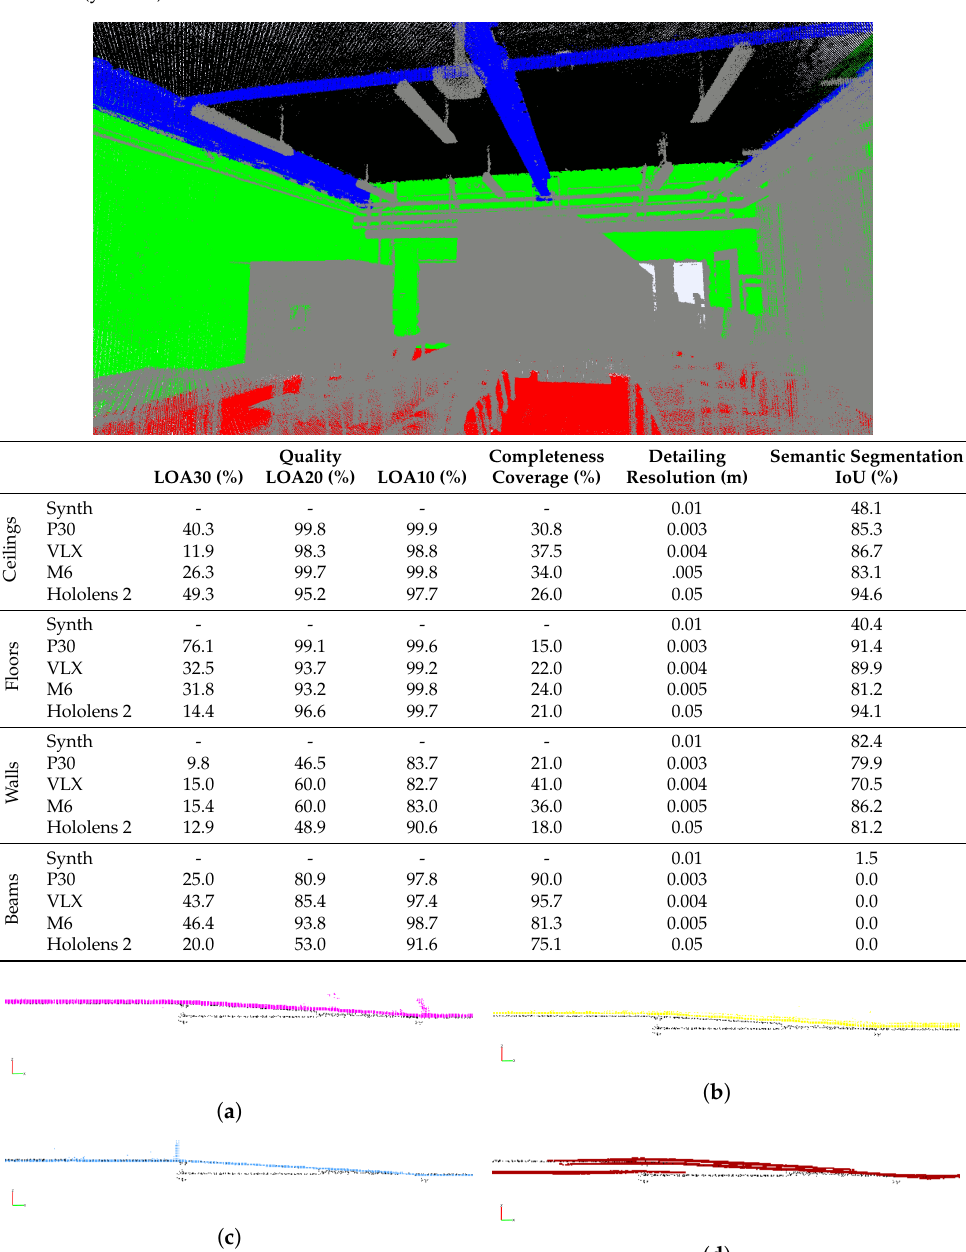
Table 6. Results of the point cloud and semantic segmentation testing (Lab 3): Comparative study of the input-validation parameters. Ceilings (black), floors (red), walls (green), beams (blue), and columns (yellow).